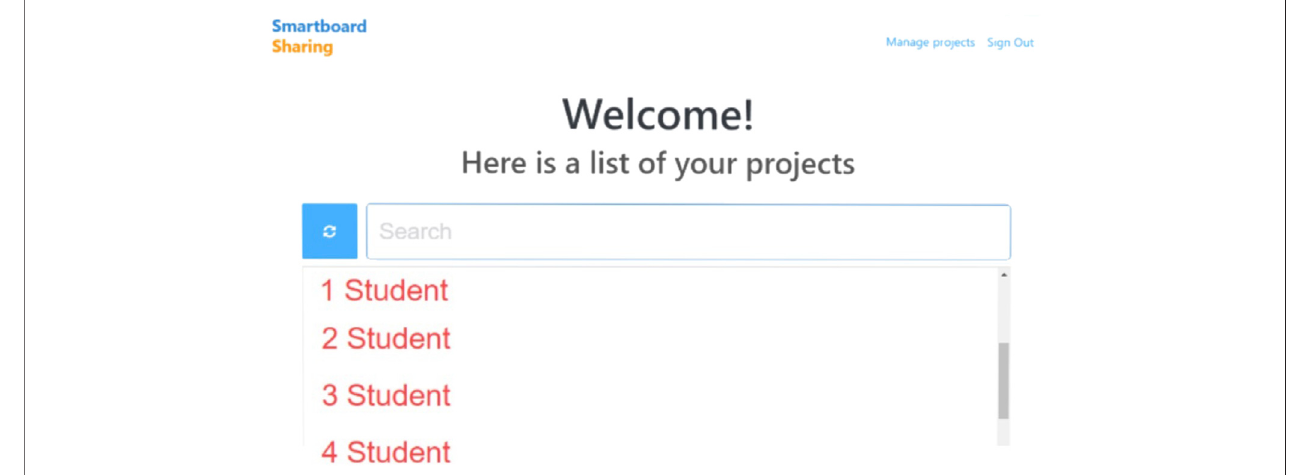
FIGURE 2 | Personalized learners projects.